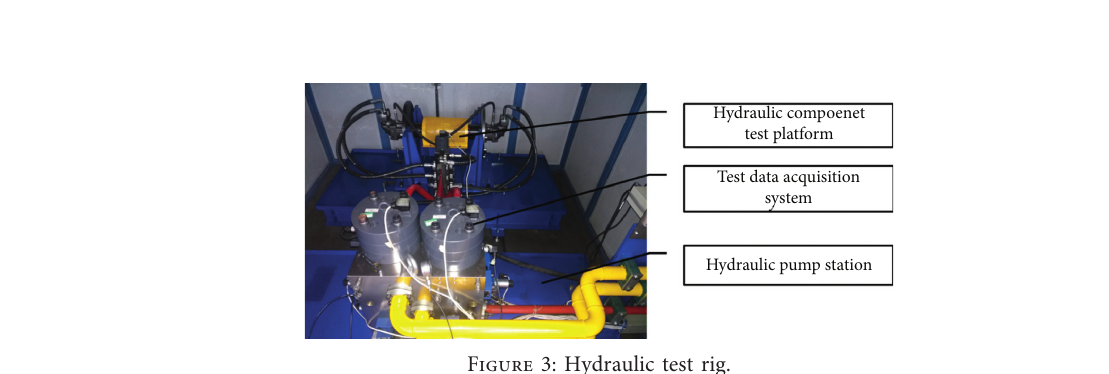
Figure 2: Integrated algorithm flow.